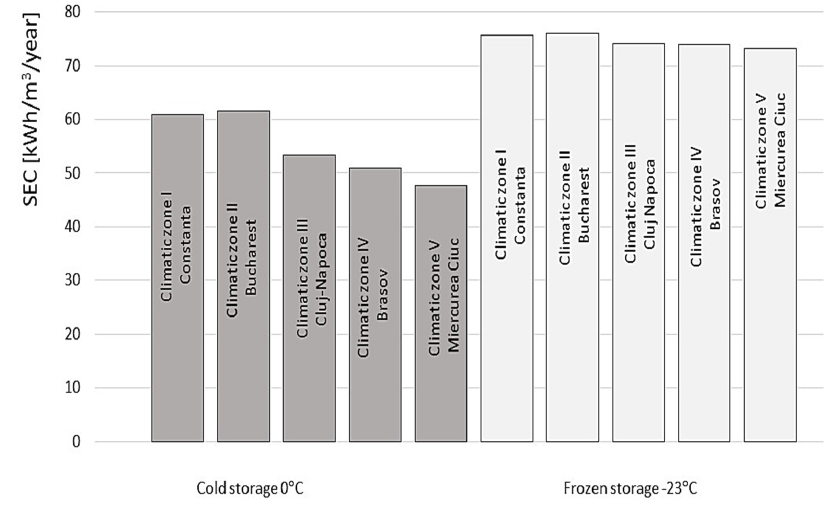
Figure 6. SEC values for the 5 climatic zones from Romania